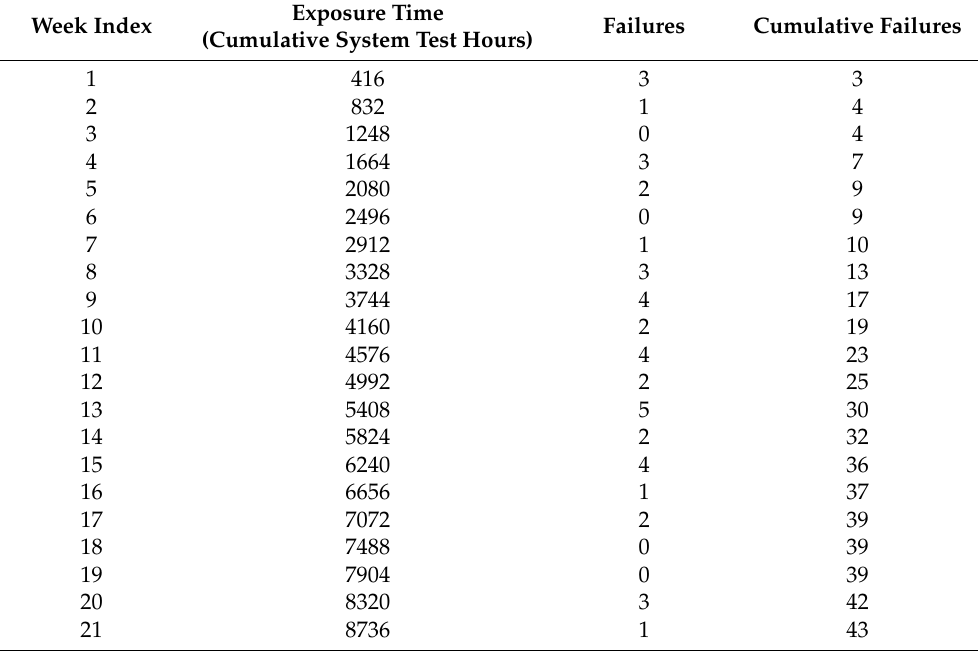
Table 4. System test data for a telecommunication system (TS)—Dataset